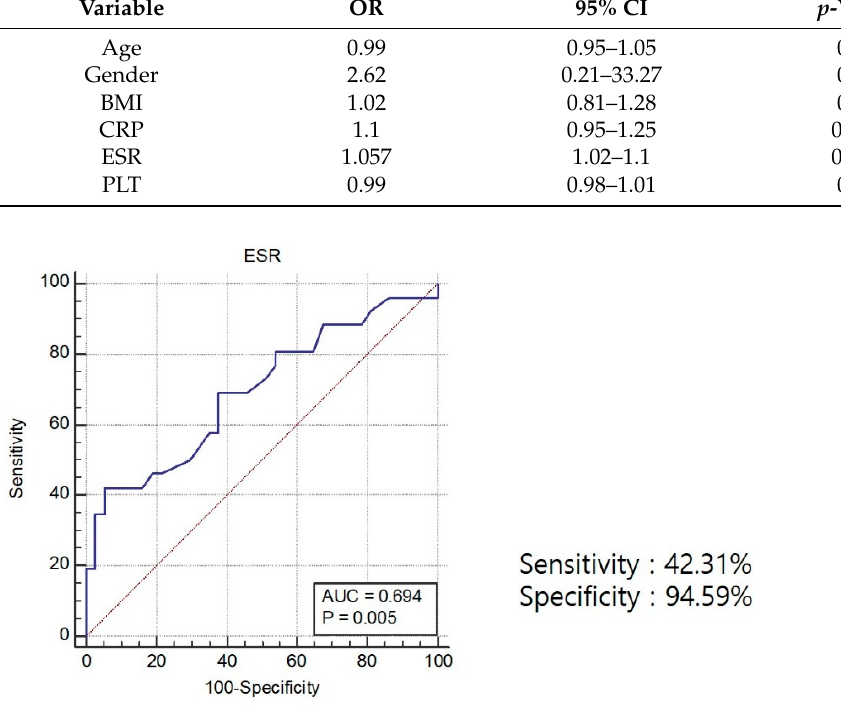
Figure 3. The area under the ROC curve for ESR for predicting a positive finding of VCE in patients with CAP was 0.69 (95% CI 0.57–0.80). ROC, Receiver operating characteristics; CI, confidence in ‐ terval.